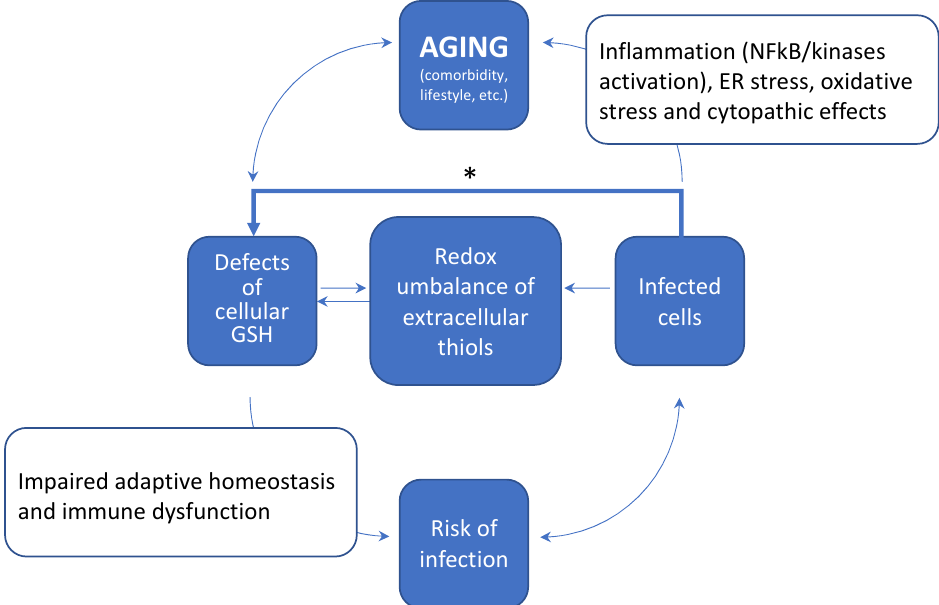
Figure 3. Age-dependent changes of tissue redox and risk of severe COVID-19. Aging promotes a progressive decline of physiological processes that modulate the tissue redox, also identified with the all-encompassing definition of “adaptive homeostasis” [29]. These processes include the homeostatic control of the levels and redox buffering properties of cellular thiols. Defects in these fundamental components, increase the risk of oxidative stress and immune dysfunction in the diseased host, ultimately reiterating the risk of SARS-CoV-2 infection and complications. In the infected cell, a decreased efficiency of the cellular metabolism and redox function of GSH is observed [8] (marked with the symbol * and discussed in Section 4) and this interferes with the redox balance of extracellular thiols, further sustaining the risk of infections and the age-related defect of thiol metabolism in the infected tissue and in the whole organism. SARS-CoV-2 infection also sustains stress kinase signalling and NFkB activation, thus stimulating the production of inflammatory cytokines in the host cell [13,58]. These pro-inflammatory events observed at the cellular level conspire with the redox defects of tissues to increase the risk of immune dysfunction and inflammatory complications that characterize the comorbidity of severe COVID-19.